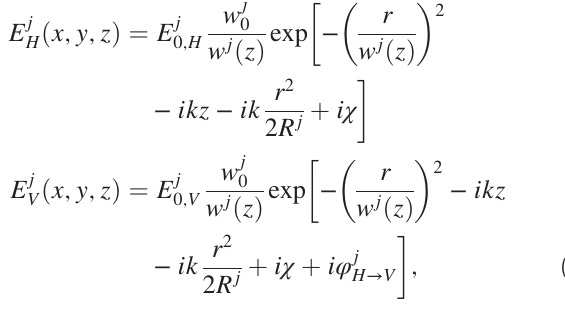
FIG. 3. Phases of the superimposed electric fields ( E 1 and E 2 ), together with the magnitude of the total electric field ( E the distance d between the sources is larger than the Rayleigh length z R of the radiation, the two sources have different phase profiles at the interaction point, hence the superposition field exhibits phase differences along the wavefront. Bottom: when the distance between the sources is smaller than z R no significant phase shift is present